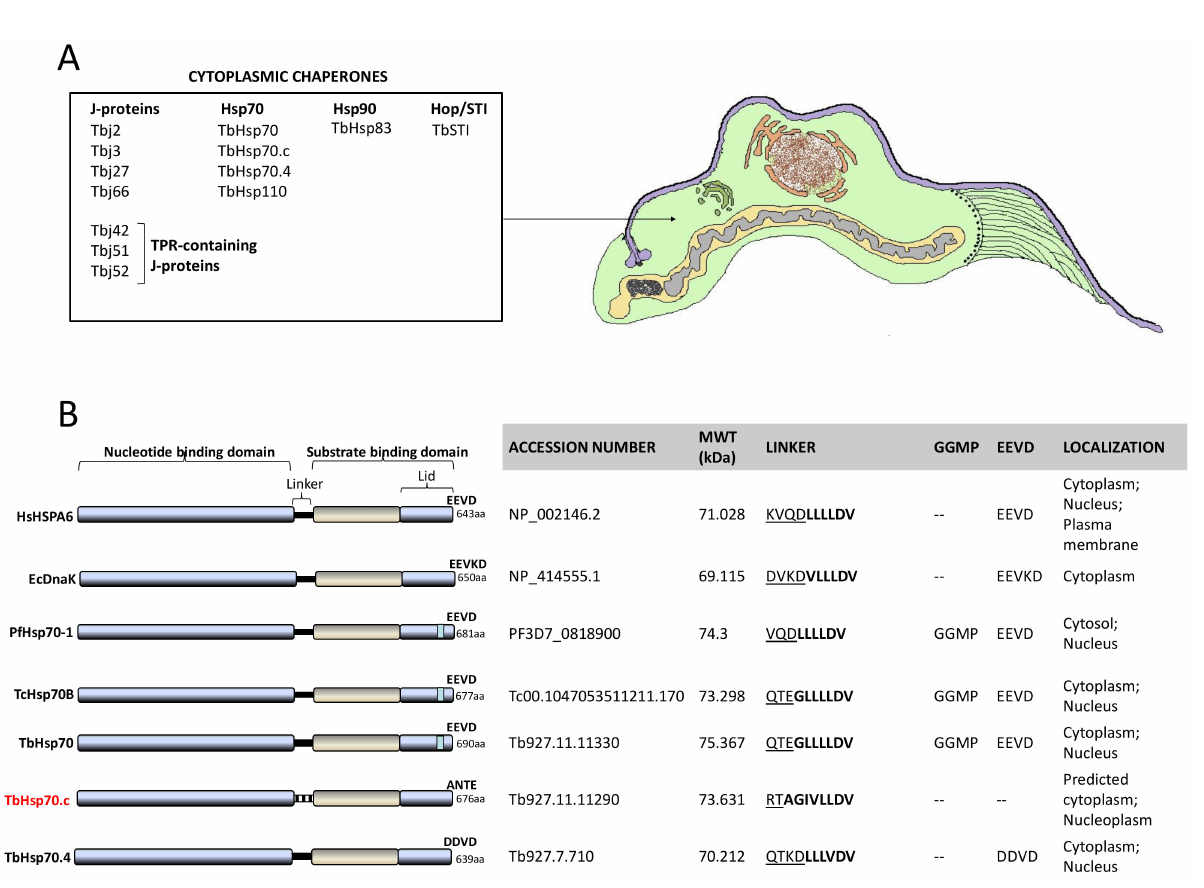
Figure 3. Cytosolic heat shock proteins of T. brucei and distinct features of TbHsp70.c. ( A ) Schematic showing organelles and structures of a bloodstream form trypanosome as would be observed in thin sections by transmission electron microscopy. ( B ) Features of canonical Hsp70s were compared to highlight distinct features of TbHsp70.c based on multiple sequence alignments [13,17]. Underlined residues represent the hydrophilic region and residues in bold represent the hydrophobic regions of the